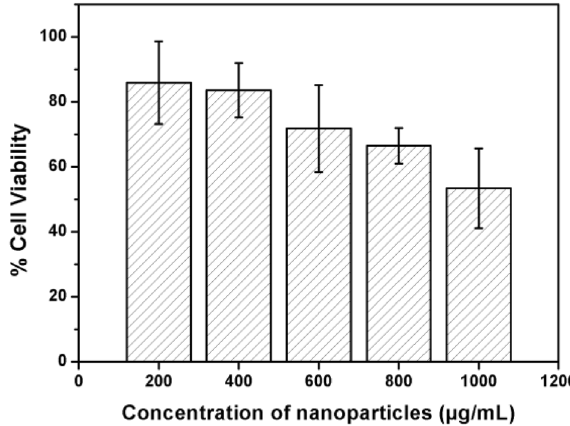
Fig. 5 Cytotoxocity of coumarin-6-PLGA nanoparticles at different concentrations. Results have been presented as mean ± SD ( n =